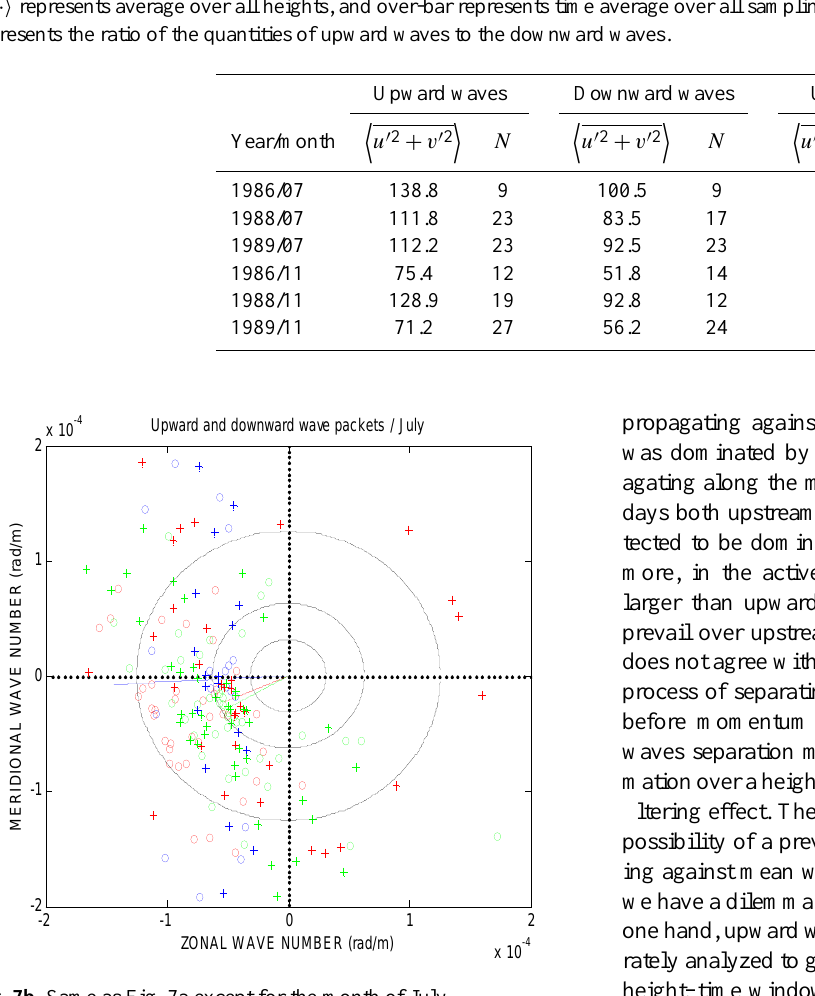
Fig.7b Same as Fig.7a except for the month of July. Fig. 7b. Same as Fig. 7a except for the month of